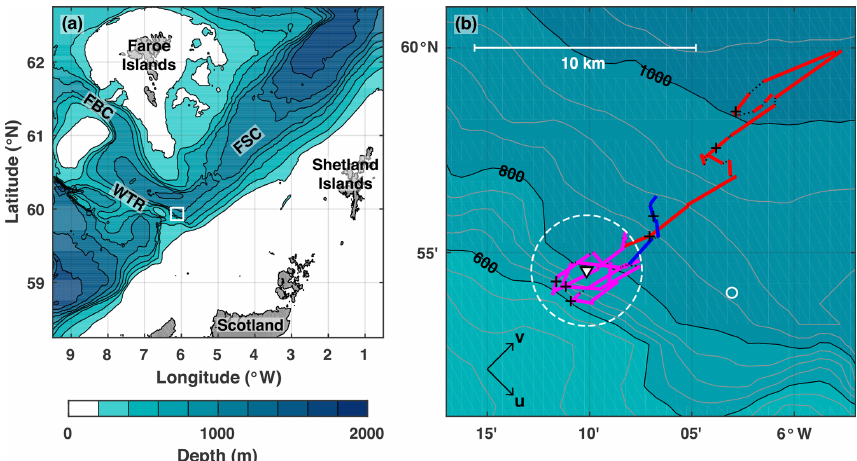
Figure 1. (a) Location of the experiment site (white square) and regional bathymetry, including the Faroe Bank Channel (FBC), Faroe– Shetland Channel (FSC), and Wyville Thomson Ridge (WTR). (b) Path of the glider over the WTR with local bathymetry ( (cid:49) 50m isobaths in grey). Dives are separated into deployment (red), on-station (magenta), and recovery (blue) sections with a black cross every 12h (00:00 and 12:00UTC). The dotted black lines are surface drift. The white triangle is the location of the ADCP mooring and the dashed white line delineates a 5km diameter “watch circle” around it. The white circle is the location of the CTD repeat station where Sherwin (1991) observed a semidiurnal internal tide. The bathymetric dataset is the GEBCO 2014 30arcsec grid (http://www.gebco.net, last access: 25 March 2015).